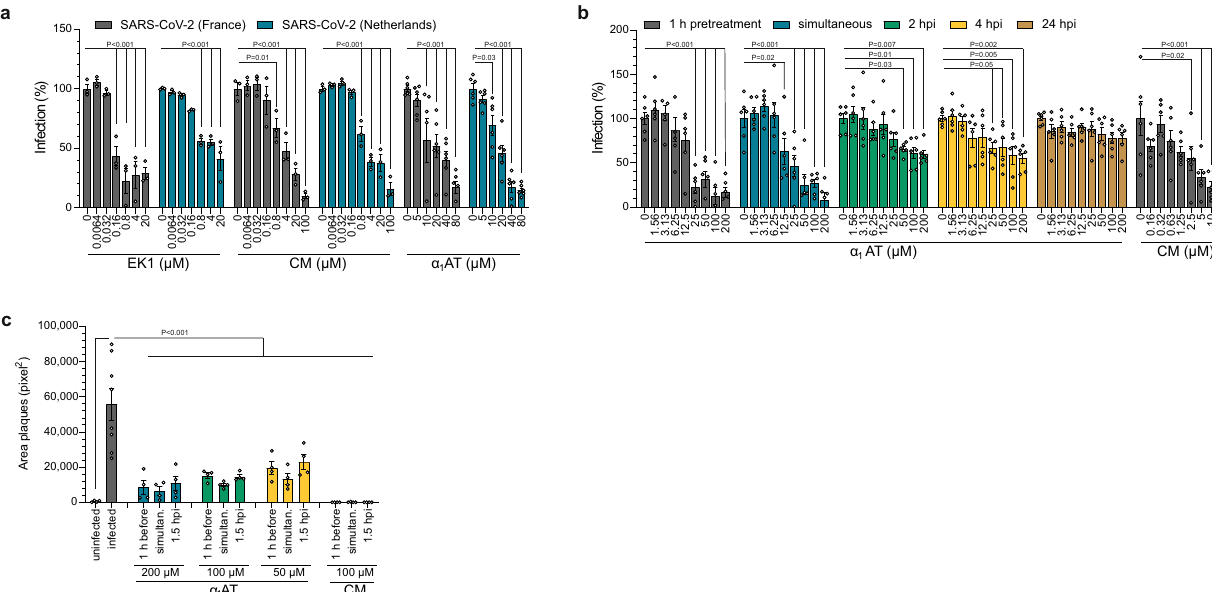
10 µM (0.5 mg/ml) of α 1 AT and then exposed to SARS-CoV-2. As control, we used 5 µM of remdesivir, which has previously been